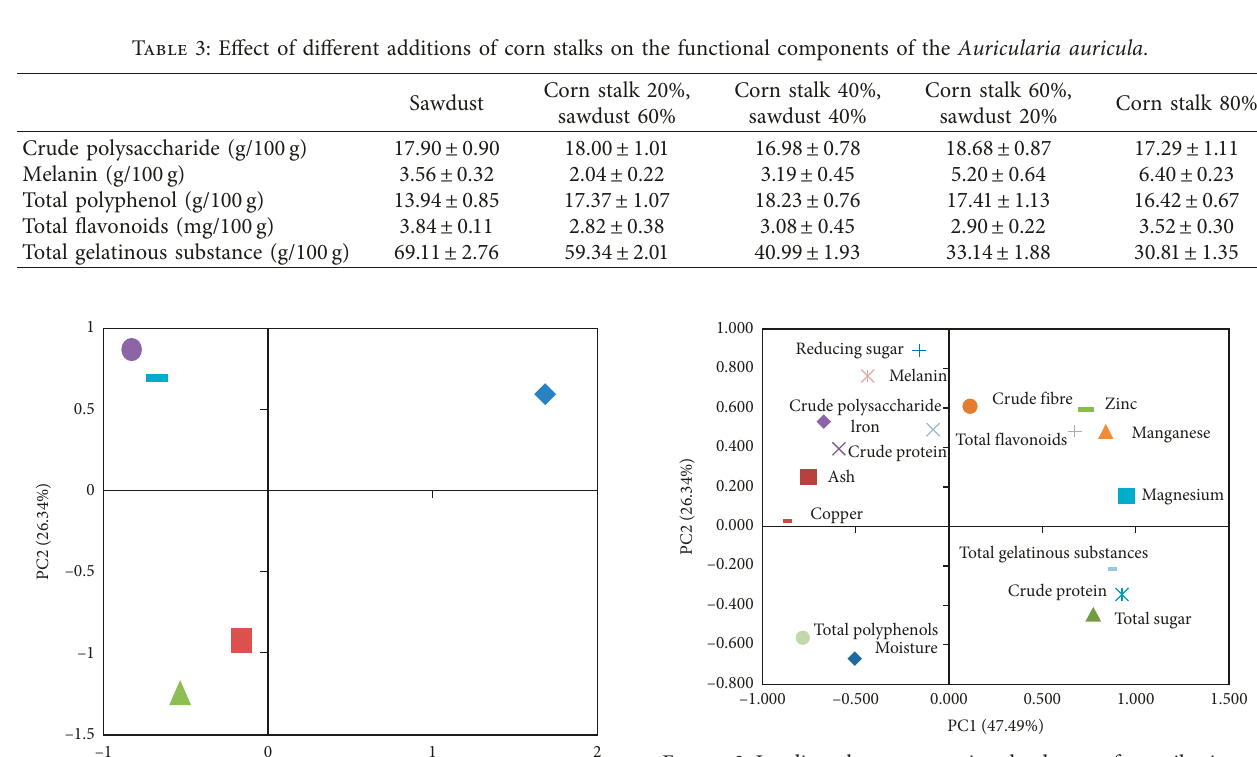
Figure 2: Loading plots representing the degree of contribution of each nutrition component to PC1 and